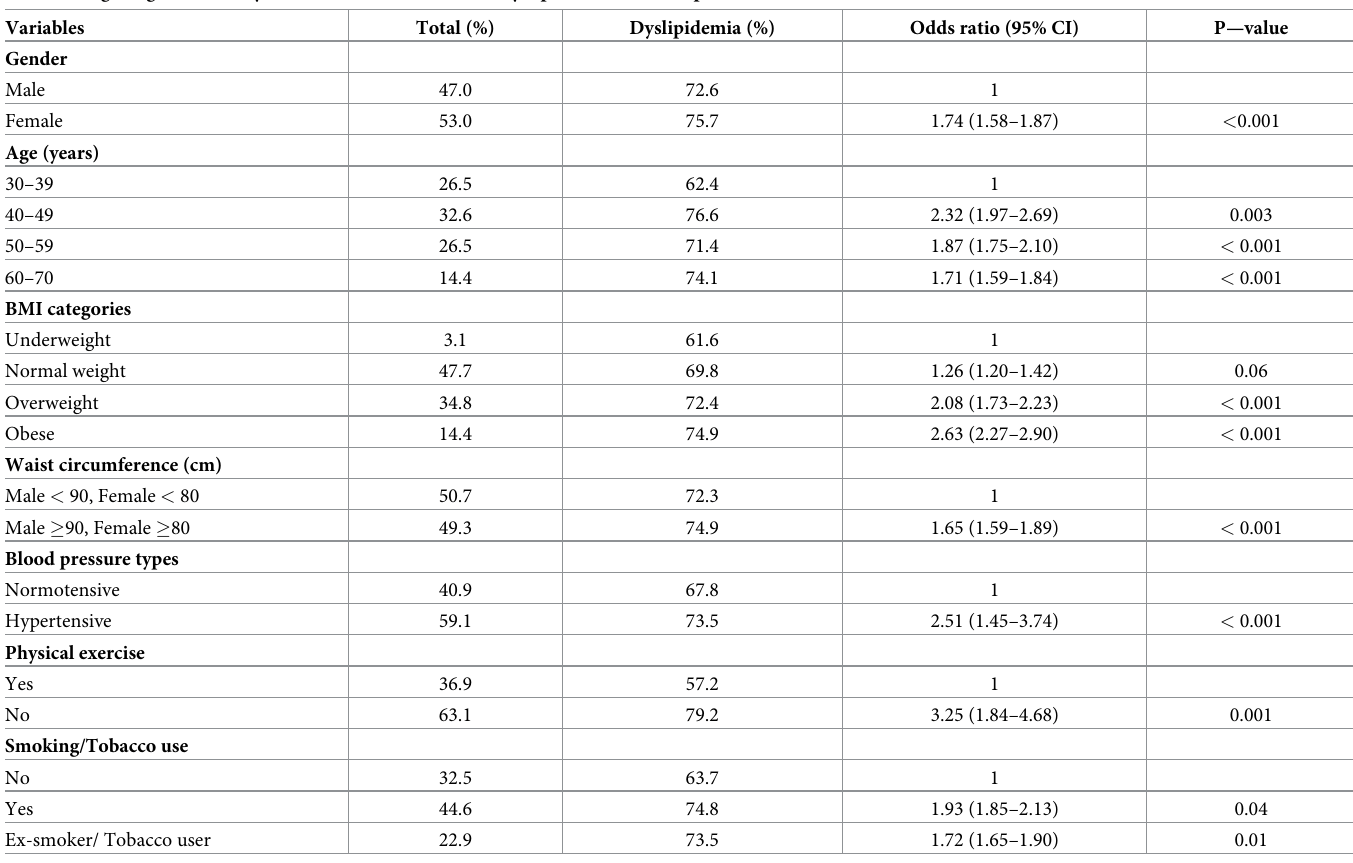
Table 5. Logit-regression analysis of associated factors with dyslipidemia in T2DM patients.